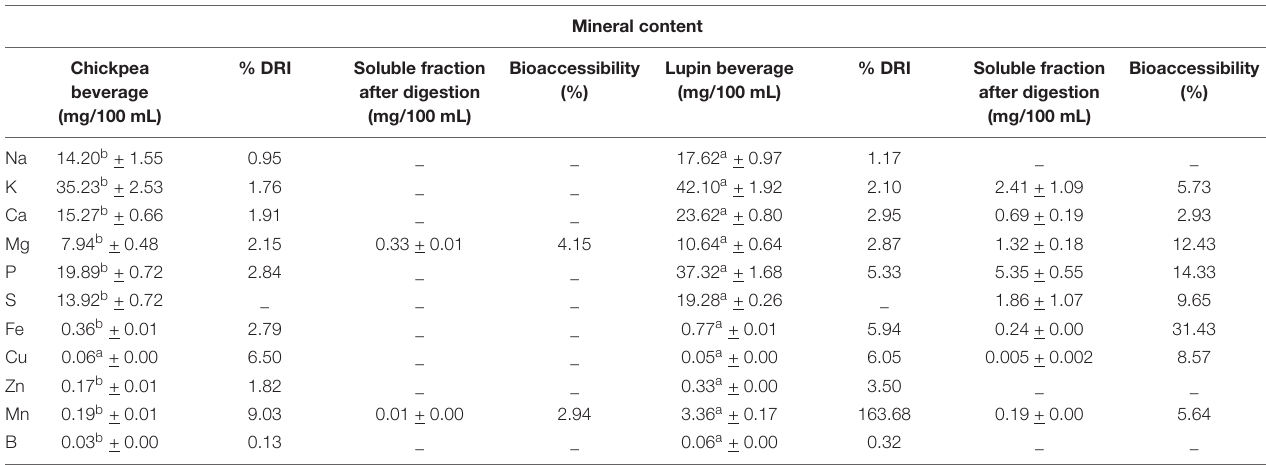
TABLE 4 | Mineral content before and after in vitro digestion of chickpea and lupin